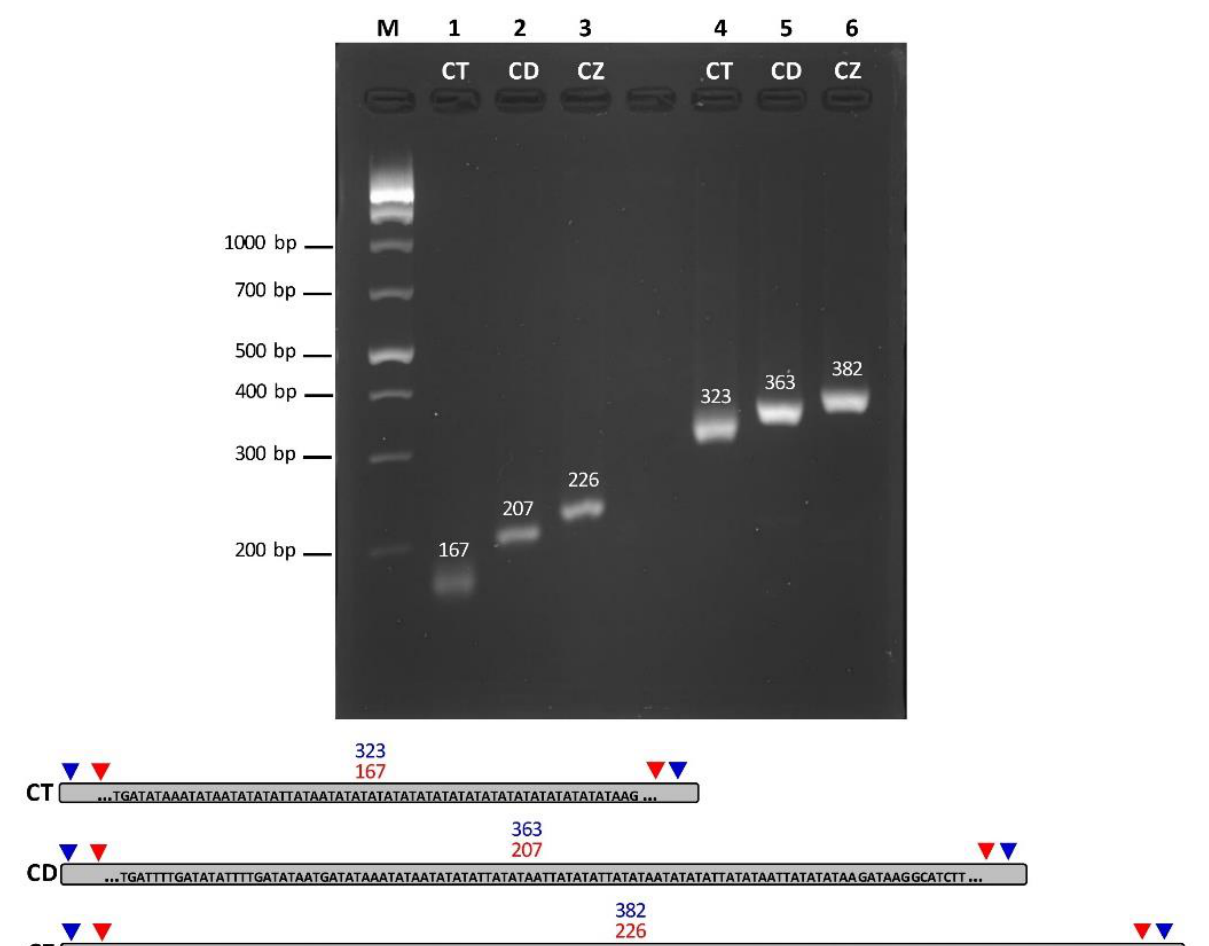
Figure 5. Analysis of PCR products by 1% agarose gel electrophoresis with graphical genomes positing primer pairs. PCR products were amplified with two primer pairs in three Ceriops chloroplasts. Lane M: DNA size marker; Lane 1: PCR product amplified with the first primer set in C. tagal (CT: 167 bp); Lane 2: PCR product amplified with the first primer set in C. decandra (CD: 207 bp); Lane 3: PCR product amplified with the first primer set in C. zippeliana (CZ: 226 bp); Lane 4: PCR product amplified with the second primer set in C. tagal (323 bp); Lane 5: PCR product amplified with the second primer set in C. decandra (363 bp); Lane 6: PCR product amplified with the second primer set in C. zippeliana (382 bp). Graphical genomes show a part of the IR region used for designing specific primers of three Ceriops species based on different SSRs. Red arrows indicate the position of the first primer set, whereas blue arrows indicate the position of the second primer set.